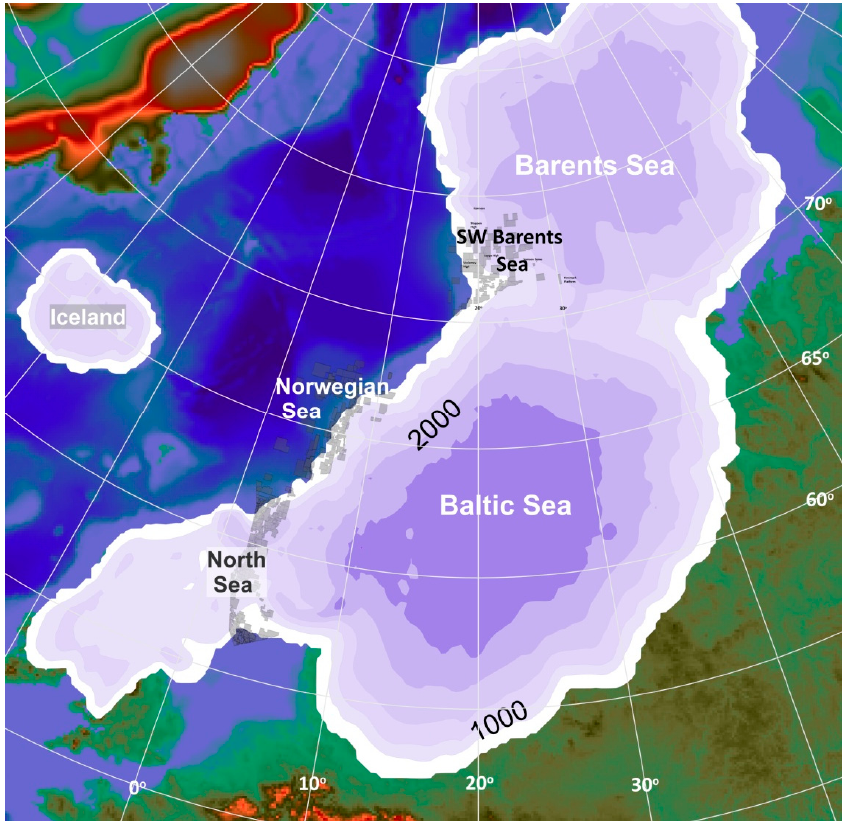
Figure 1. Extent (based on [36]) and maximum thickness model for the Last Glacial Maximum (LGM), from [3]. The production licenses (from www.npd.no) in the Norwegian continental shelf are shown by grey polygons.